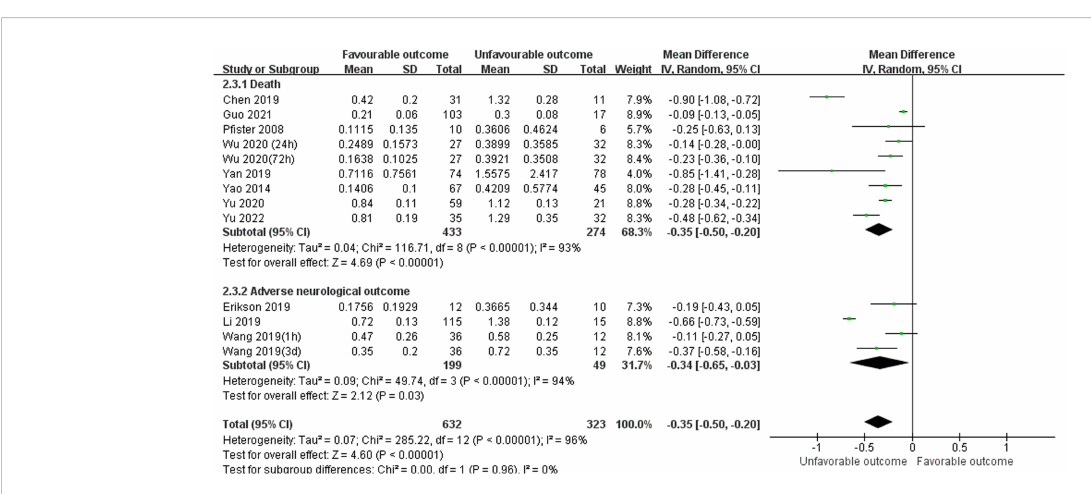
FIGURE 5 Meta-Analysis forest plot: MDs of serum S100B levels between Favorable outcomes and Unfavorable